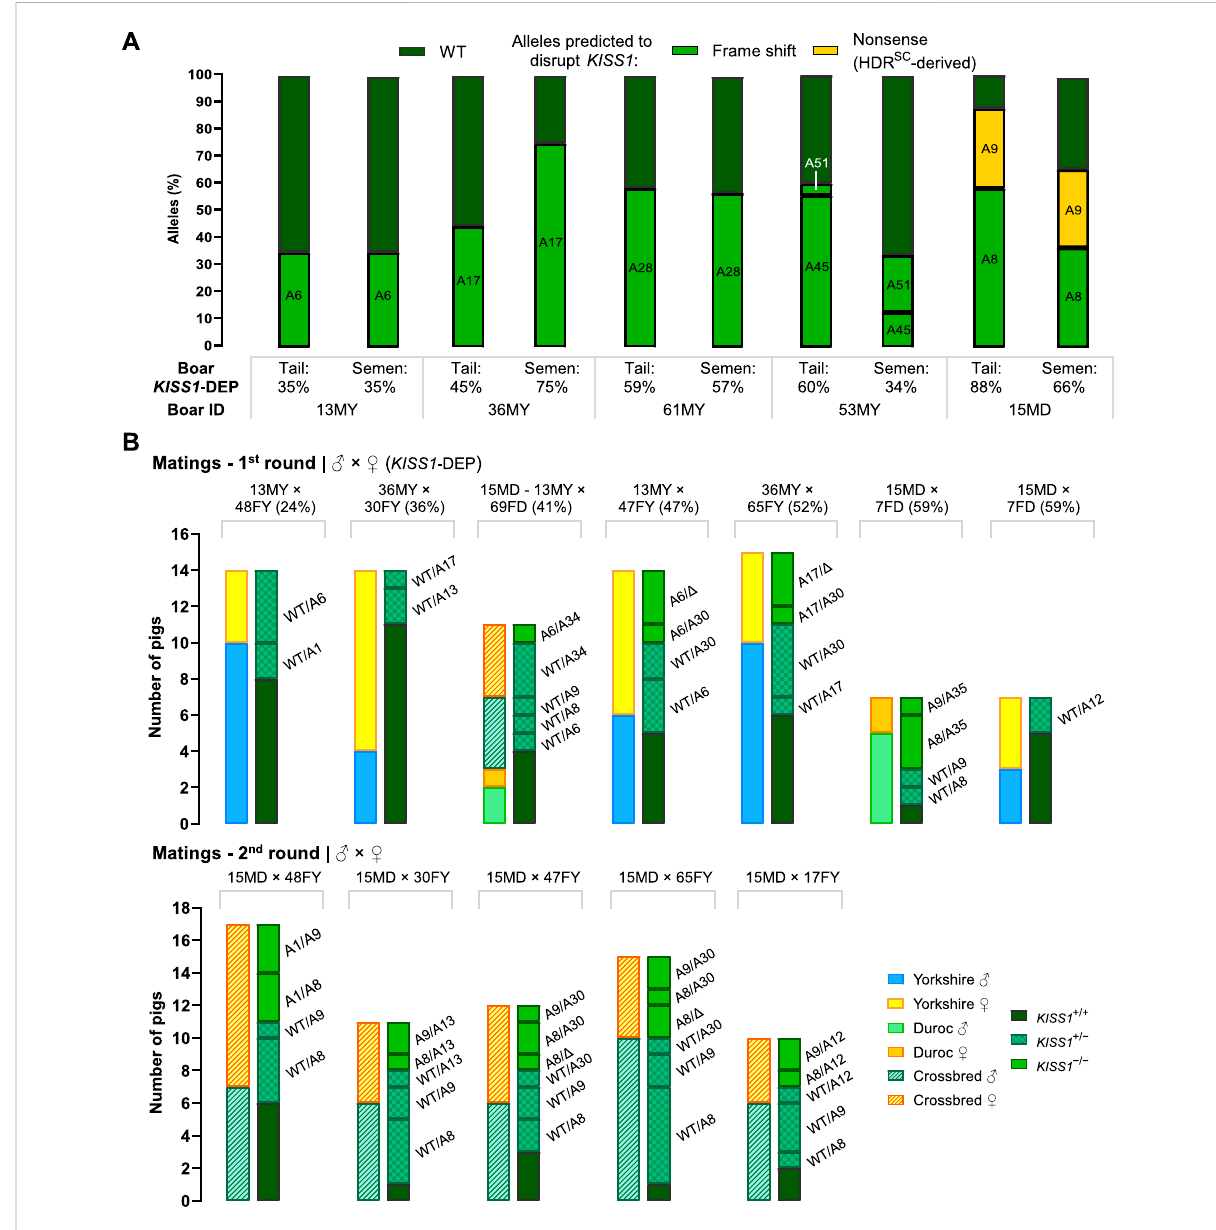
FIGURE 5 Con fi rmation of KISS1 -edited allele transmission. (A) KISS1 allele frequencies of mosaic F0 boar candidates for breeding, calculated using DNA fromtailtissueandspermatozoa. (B) Inherited KISS1 allelesbyF1piglets,andthenumberofgenotypedpigsineachlitteraccordingtotheirsex-breed ( fi rst bar) or genotype category (second bar). “ DEP ” stands for disruptive editing percent and “ Δ ” means